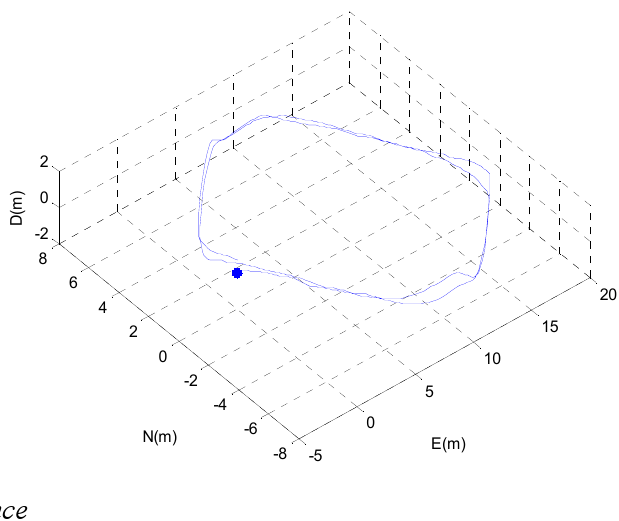
Figure 2. The estimated 3-D trajectory of the pushcart.